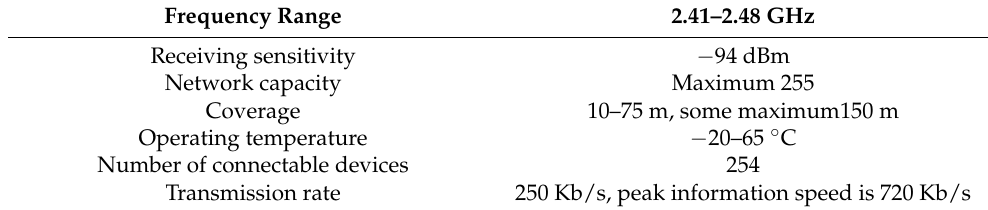
Table 2. Partial data of Zigbee